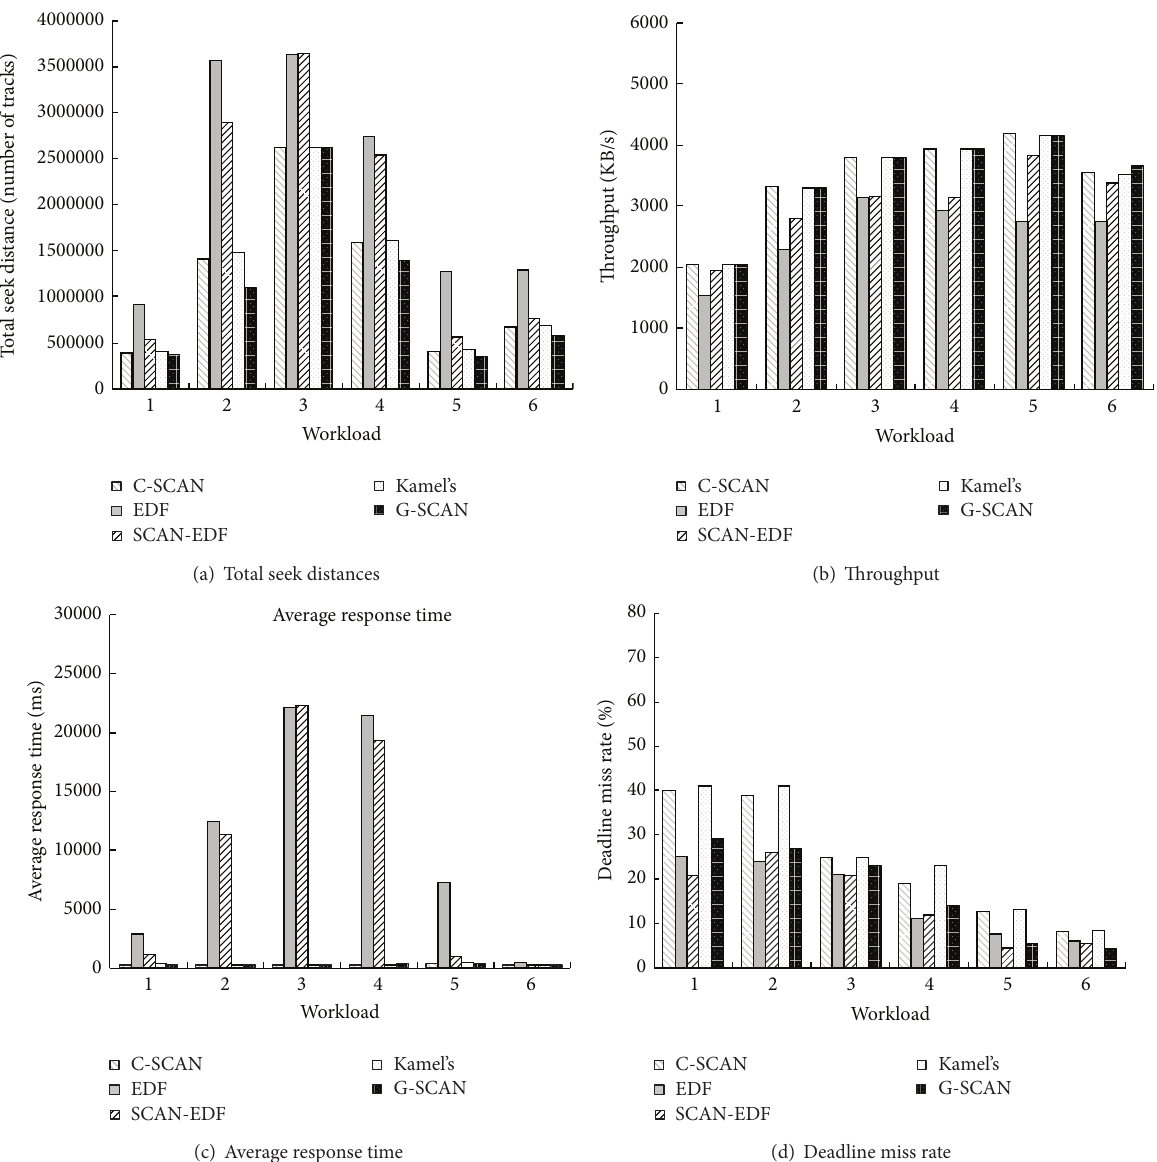
Figure 5: Performance comparison with various